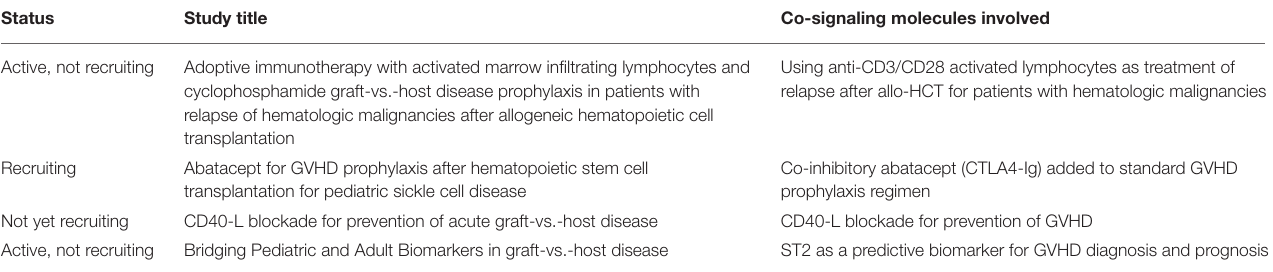
TABLE 1 | Currently ongoing clinical trials involving co-stimulatory or co-inhibitory